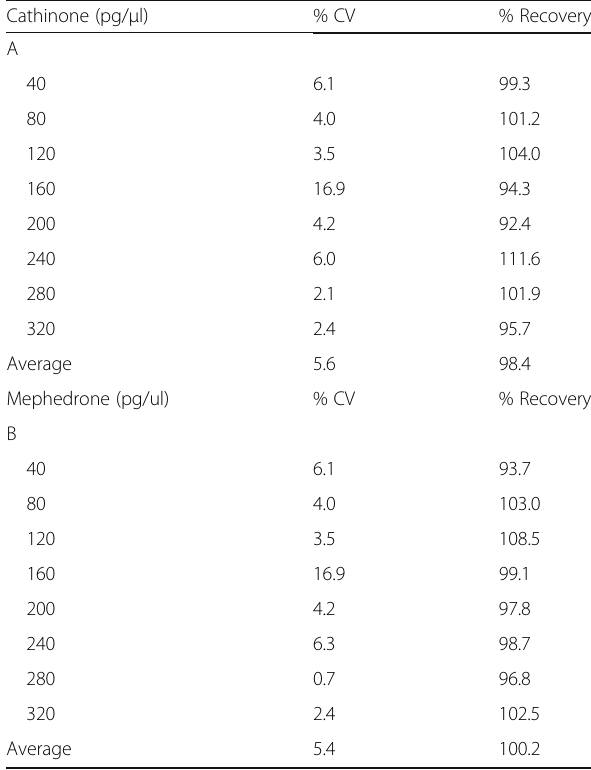
Table 3 Matrix effect for cathinone and mephedrone in plasma Cathinone (pg/ μ l) %